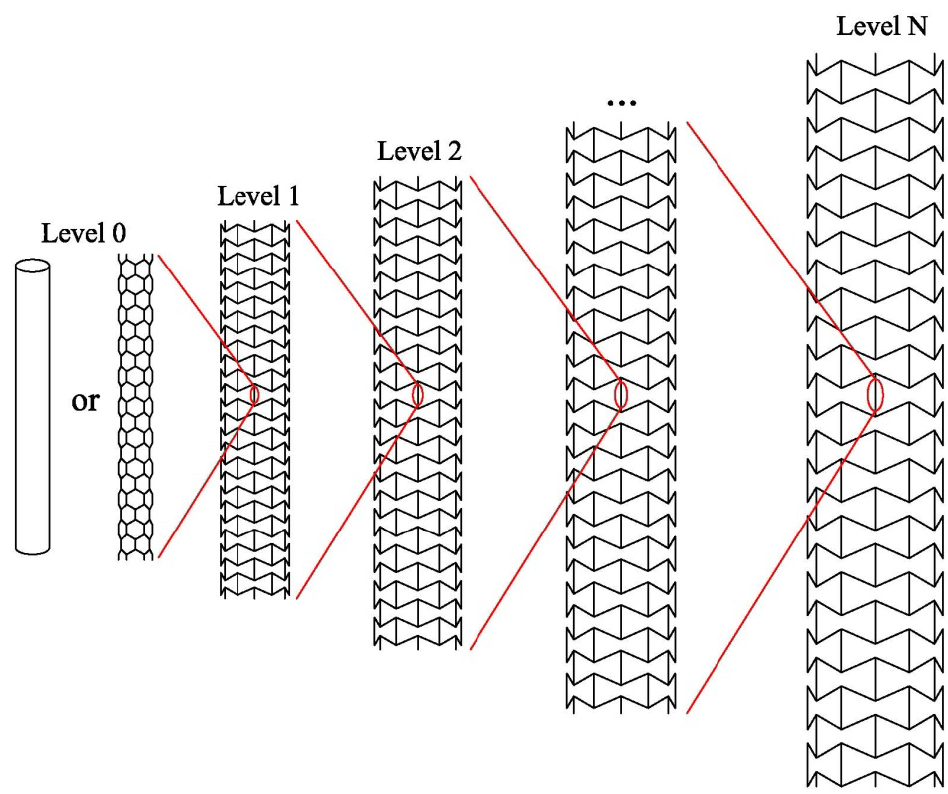
Figure 1. Schematics of the N -level hierarchical tube with a negative Poisson’s